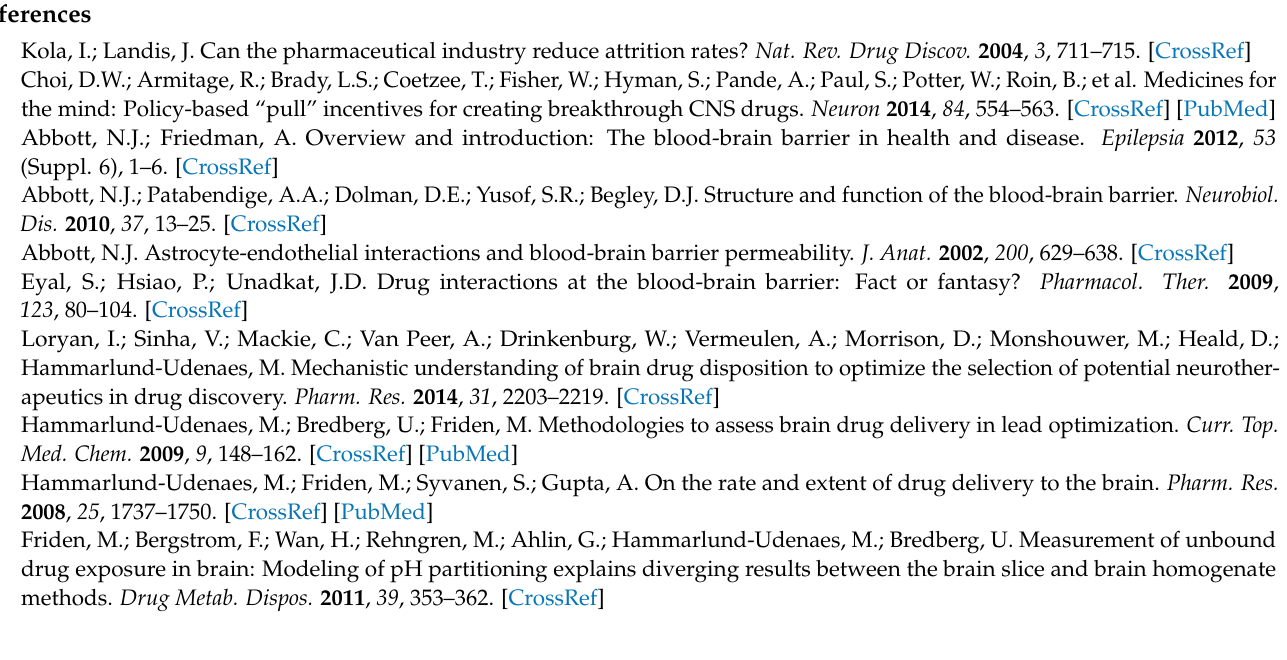
observed vs. predicted logVu,brain values from PLS Model 12; Figure S22: DmodY bar plot for PLS Model 12 of logVu,brain. Table S1: Compounds included in the dataset: pharmaceutical classification, chromatographic data, and lipophilicity parameters; Table S2: Brain disposition data, i.e., Kp,brain, Kp,uu,brain, fu,brain, and Vu,brain for the investigated compounds; Table S3: Variable Importance to Projection (VIP) values in PLS Model 4 for logKp,uu,brain on the basis of biomimetic properties, lipophilicity, and computational descriptors; Table S4: Observed and predicted logKp,uu,brain values by PLS Model 4, based on computational descriptors; Table S5: Experimental and predicted logBB values by MLR and PLS models; Table S6: Experimental and predicted logKb values by MLR and PLS models; Table S7: Observed vs. predicted fu,brain correlation: fu,brain = a × fu,brain,pred + b; Table S8: Experimental and predicted logVu,brain values by MLR and PLS